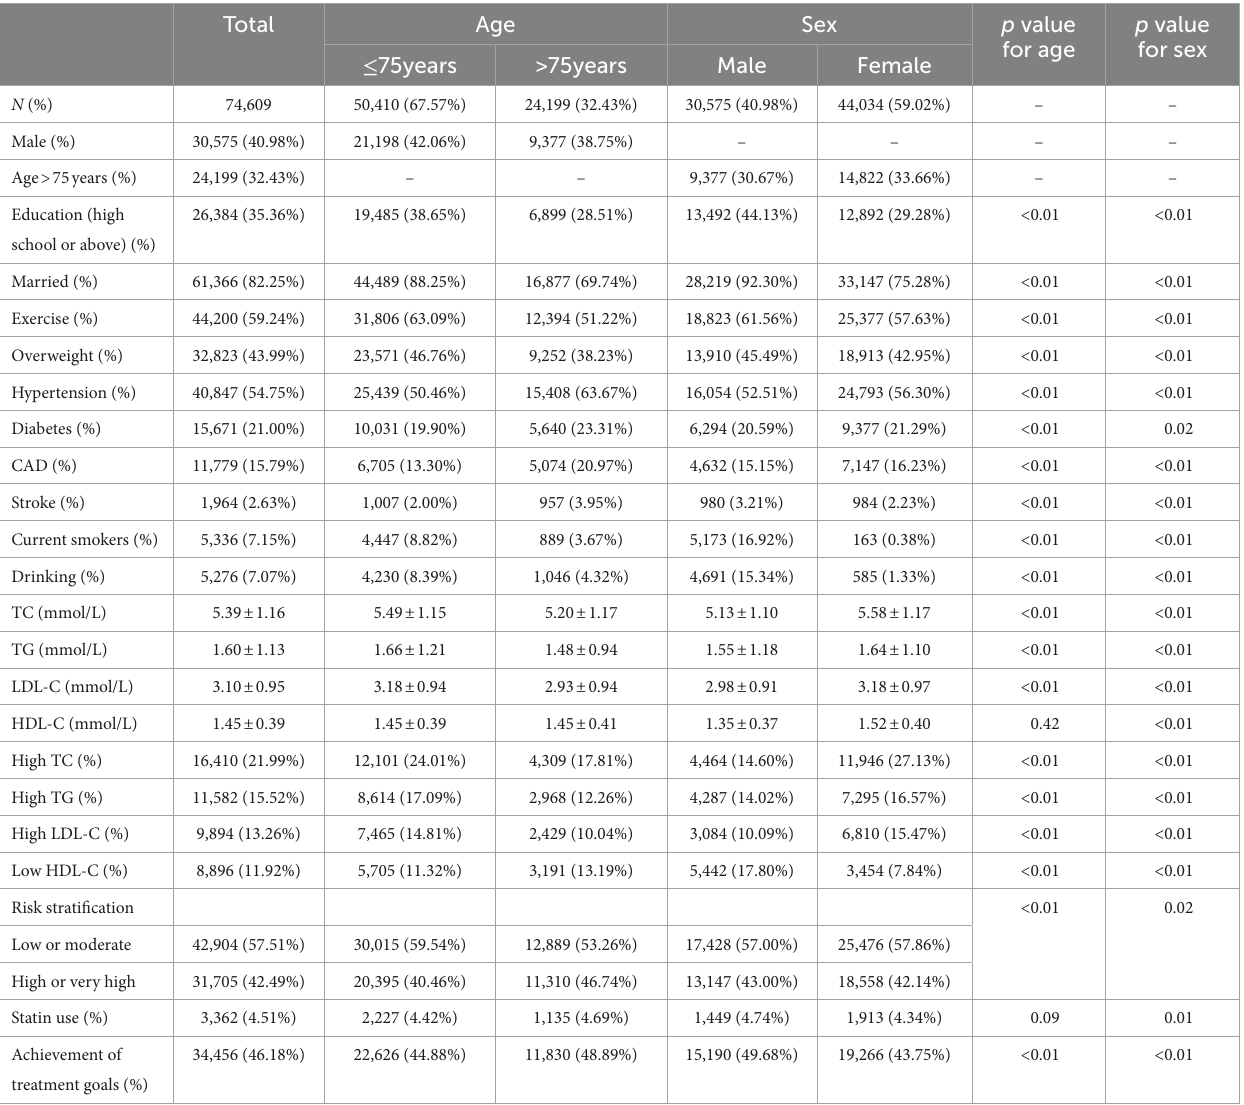
TABLE 1 Baseline characteristics of participants by age and sex in